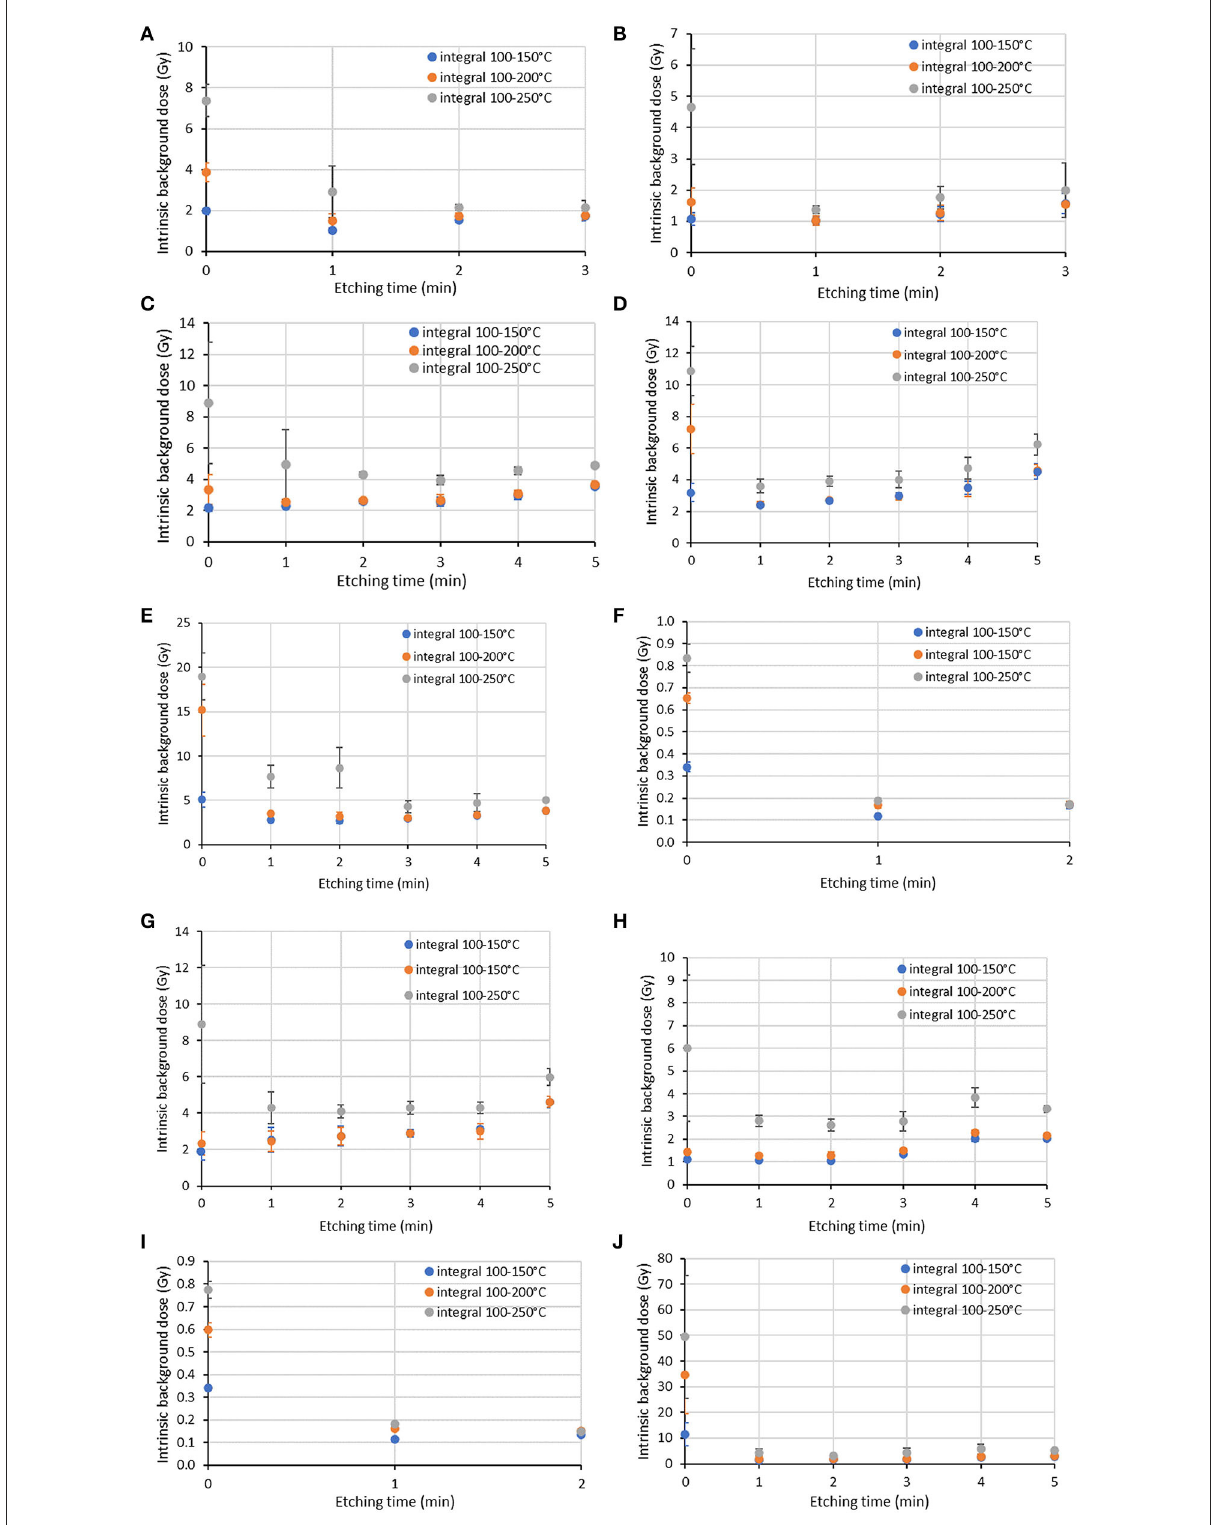
FIGURE4 Variation of intrinsic background dose (Gy) with etching time for three integration ranges (100–150 ◦ C, 100–200 ◦ C, and 100–250 ◦ C). Mean and standard deviation as error bars for three aliquots are shown. Screen protector ID: (A) P4, (B) P5, (C) P6, (D) P7, (E) P14, (F) P18, (G) P20, (H) P21, (I) P24, (J)